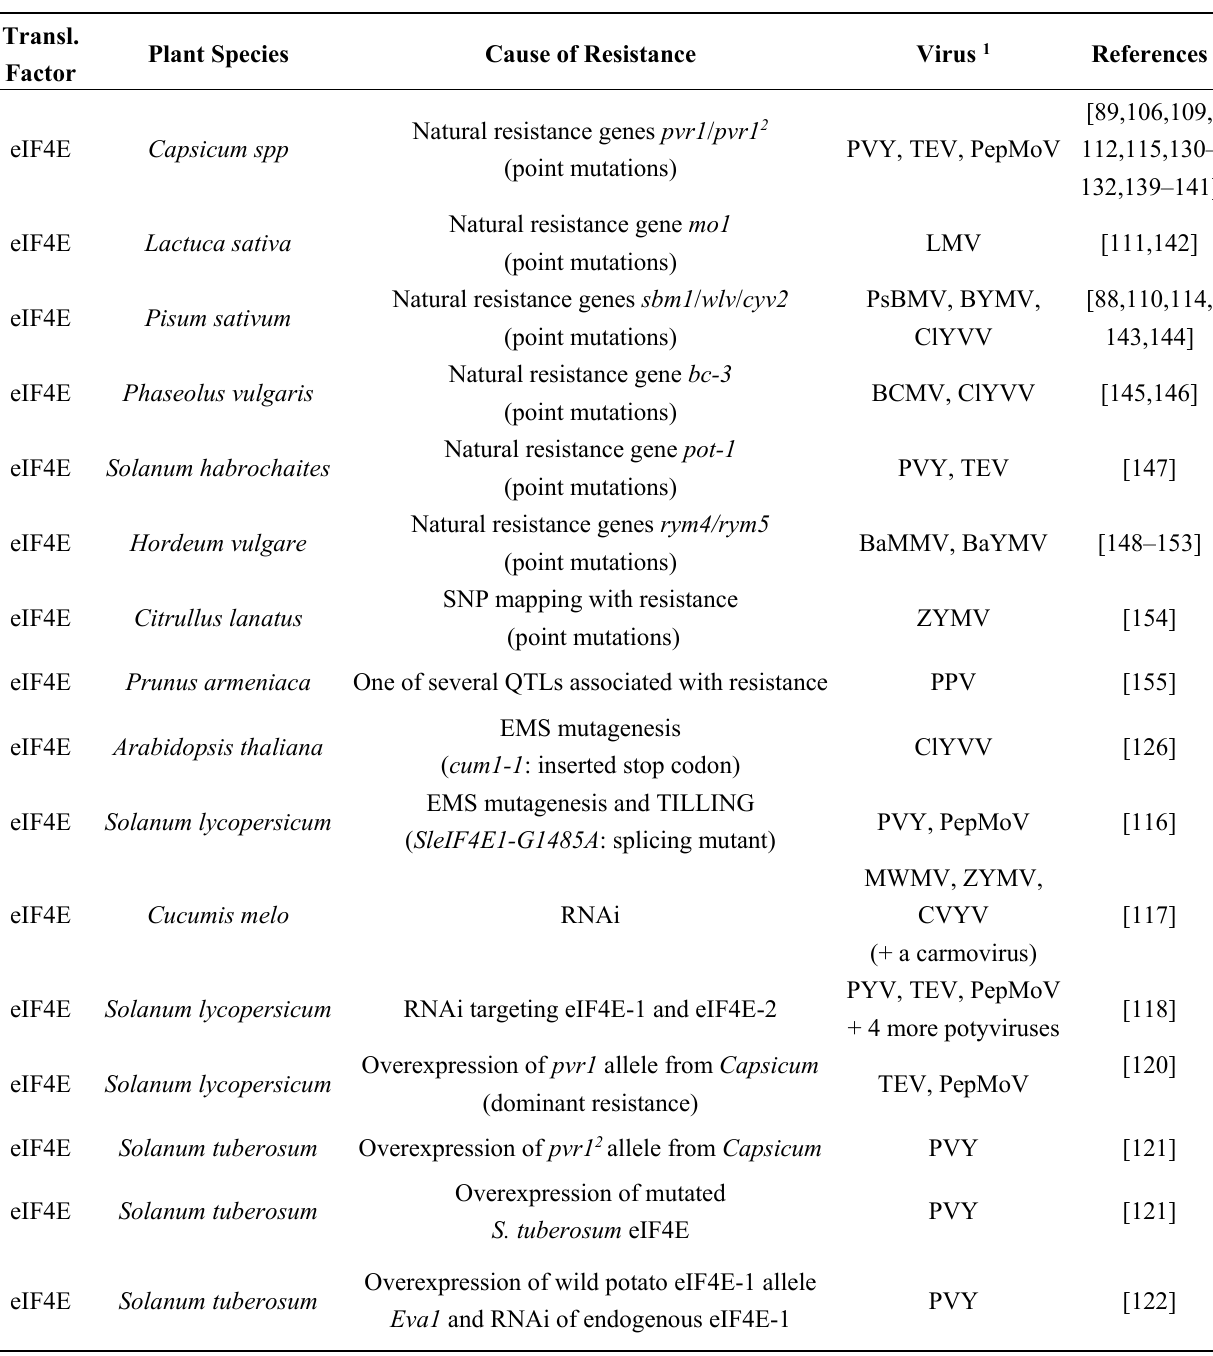
Table 1. Resistance to potyvirids based on eIF4E or